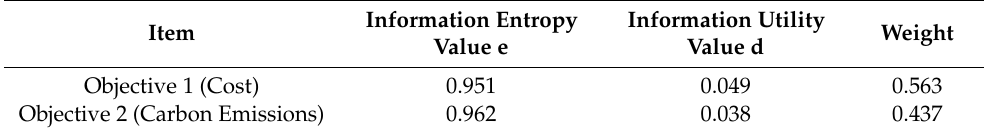
Table 5. Results of weights determined by entropy weight method.